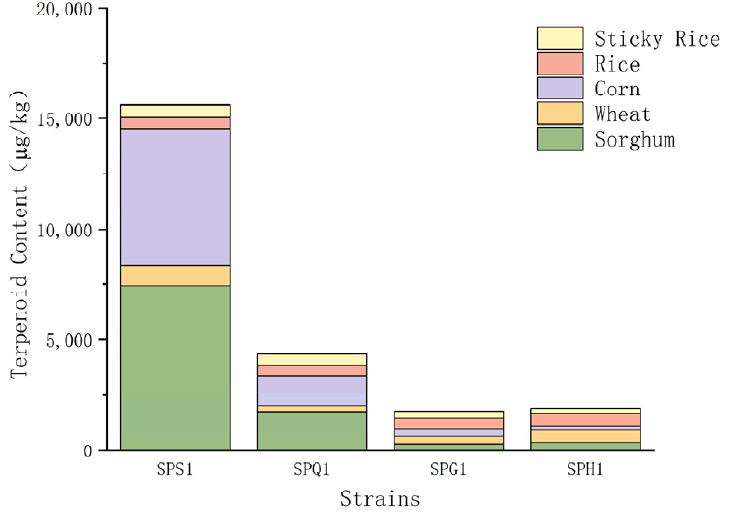
Figure 5. Content of terpenoid products from solid-state fermentation of different strains at 28 days.